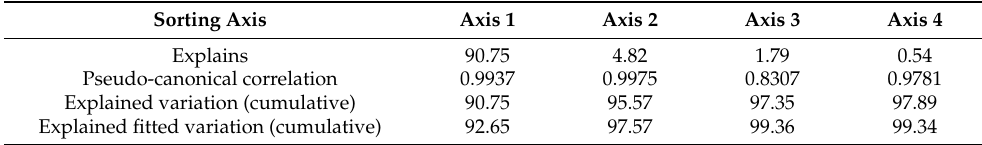
Table 3. Redundancy analysis of the component content in the plantation.